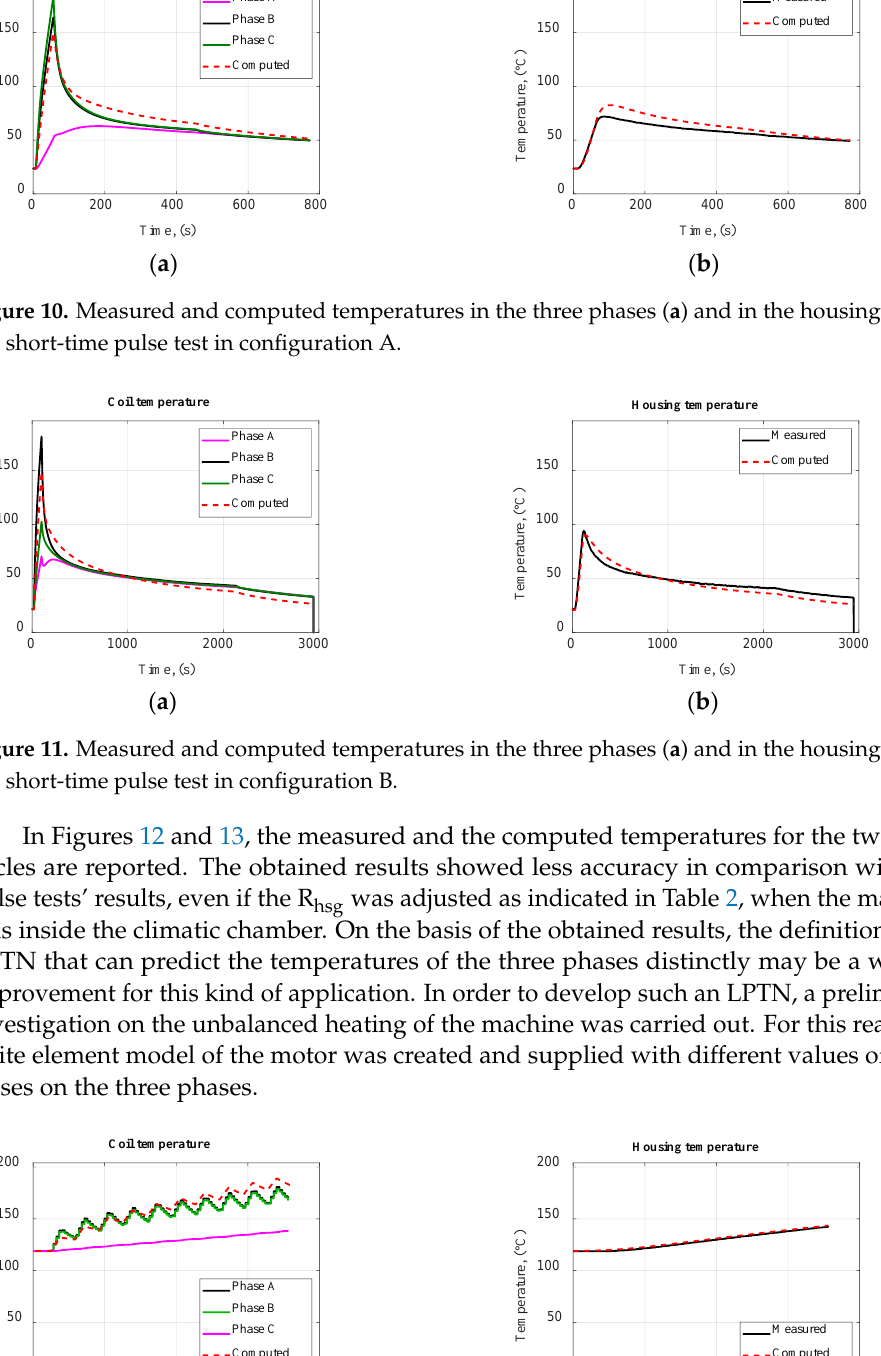
Figure 9. Measured and computed temperatures in the three phases ( a ) and in the housing ( b ) for the long-time pulse test in configuration B.